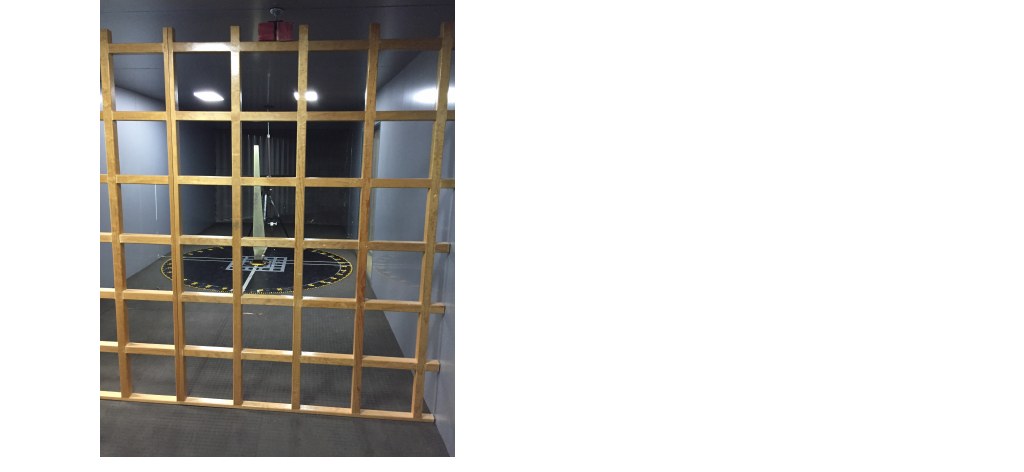
Figure 12. Experimental set-up for wind tunnel experiments: passive grid, blade, and laser vibrometer. Time-domain velocity measurements are shown in Figure 13. After 18 s of running the test, as shown on the right side of Figure 13, the fan of the wind tunnel was powered off to generate the free vibrations condition for the blade; at this moment, the algebraic identifier is engaged to estimate in an online fashion the natural frequencies and damping ratios of the first six modes of the blade.